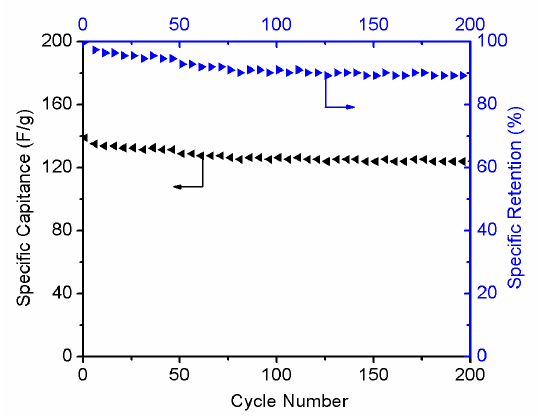
Figure 12. Cycling performance of r-GO electrodes at 1 A g − 1 and specific retention.